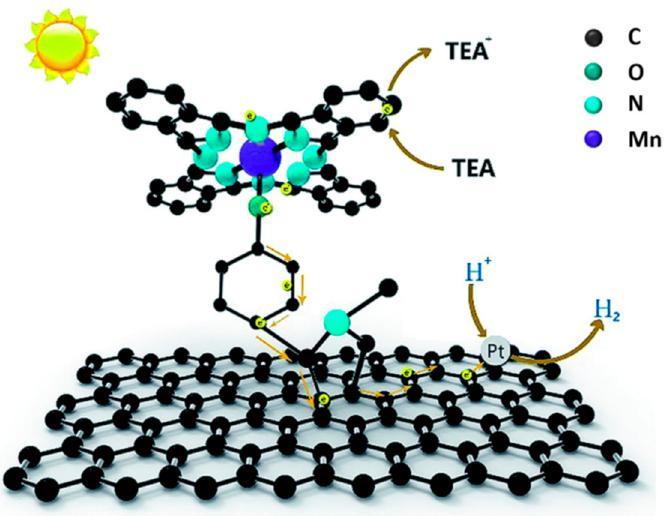
Figure 23. Schematic representation of MnPcG complex and of its photocatalytic activity in the presence of Pt nanoparticles and triethylamine (TEA) as sacrificial reducing agent. Reproduced from [133] with the permission of the Royal Society of